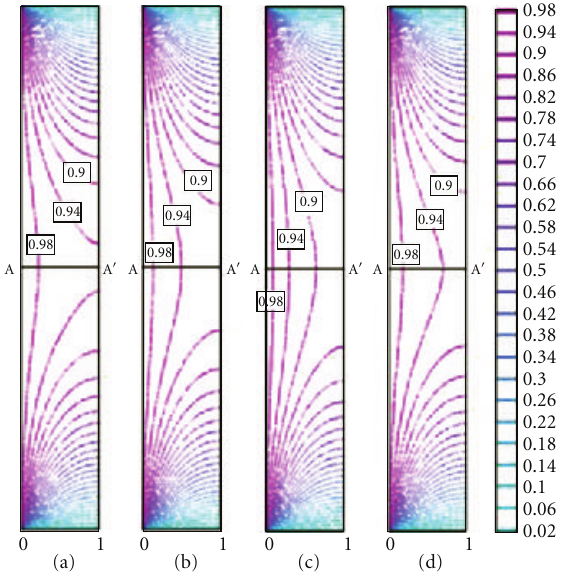
Figure 8: Distribution of dimensionless overpotential at l = 25 μ m, a = 1 . 0 × 10 5 m − 1 , E 0 = 0 . 5V, κ e = 3 . 4 Ω − 1 m − 1 , D e = 3 . 04 × = 1 . 0M; (b) T = 333 K, c 0 = 10 − 10 m 2 s − 1 ; (a) T = 303 K, c 0 M M = 1 . 0M; (d) T = 333K, c 0 = 0 . 5 1 . 0M; (c) T = 363 K, c 0 M M